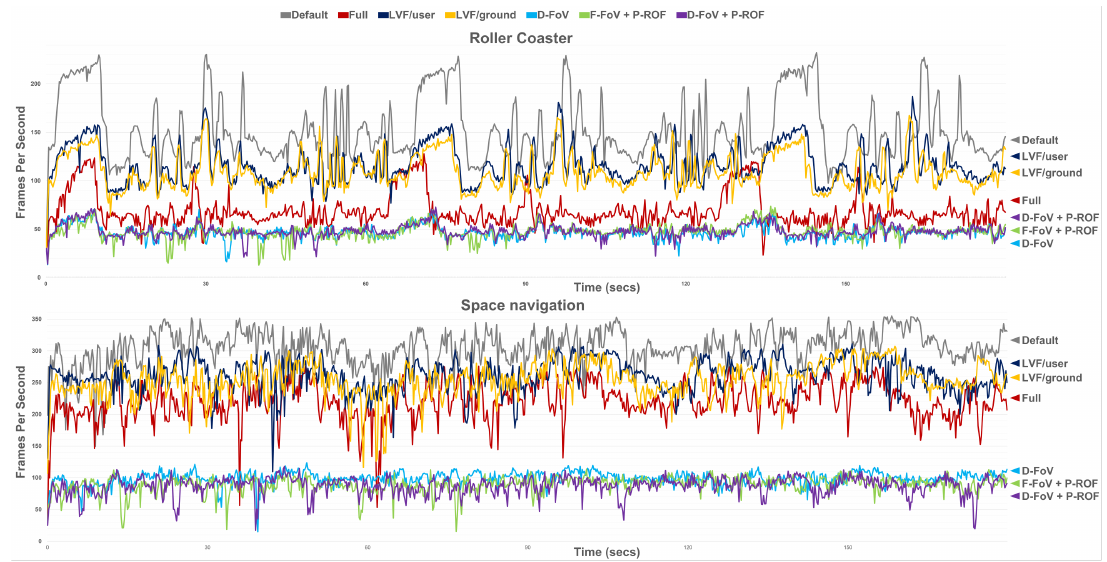
Figure 10. System performance of various sickness reduction methods: (1) default: original content without any provision for sickness and with full FoV; (2) full: overlaid with reverse optical flow over the entire full FoV; (3) D-FoV: FoV dynamically changed; (4) F-FoV+PROF: full FoV and reverse optical flow overlaid only in the periphery; (5) D-FoV+P-ROF: dynamically changed FoV and reverse optical flow overlaid only in the periphery; (6) LVF/user: reverse optical flow overlaid only in the lower visual field with respect to the user; (7) LVF/ground: reverse optical flow overlaid only in the lower visual field with respect to the ground. The data showed that the performance was the best in the order of: default > LVF/user, LVF/ground > Full > D-FoV, D-FoV+P-ROF,